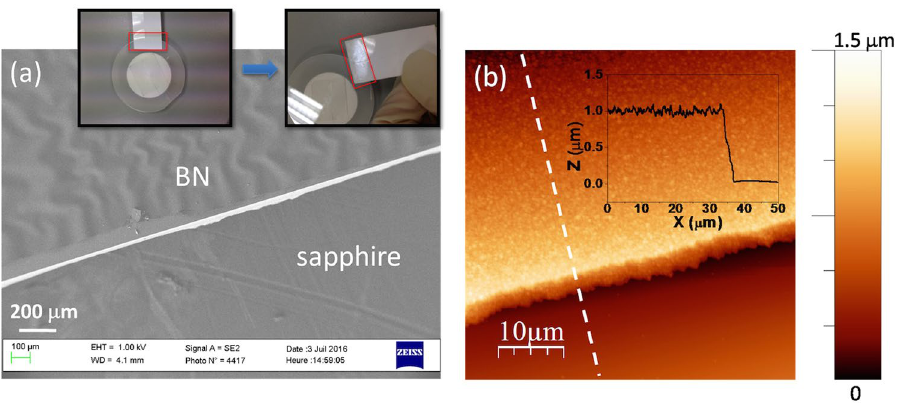
Figure 3. ( a ) Scanning electron microscopy (SEM) image focused at the edge where BN was lifted, and inset shows a lift-off and transfer process by simply using a scotch. ( b ) AFM image at the boundary with a height profile in the